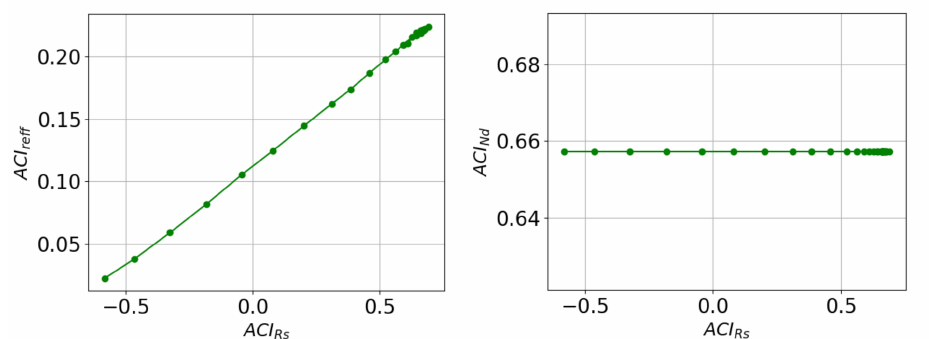
Figure 16. Relation between the ACI Nd and ACI ref f with the ACI Rs considering ACI values where Z e greater than − 60 dB.